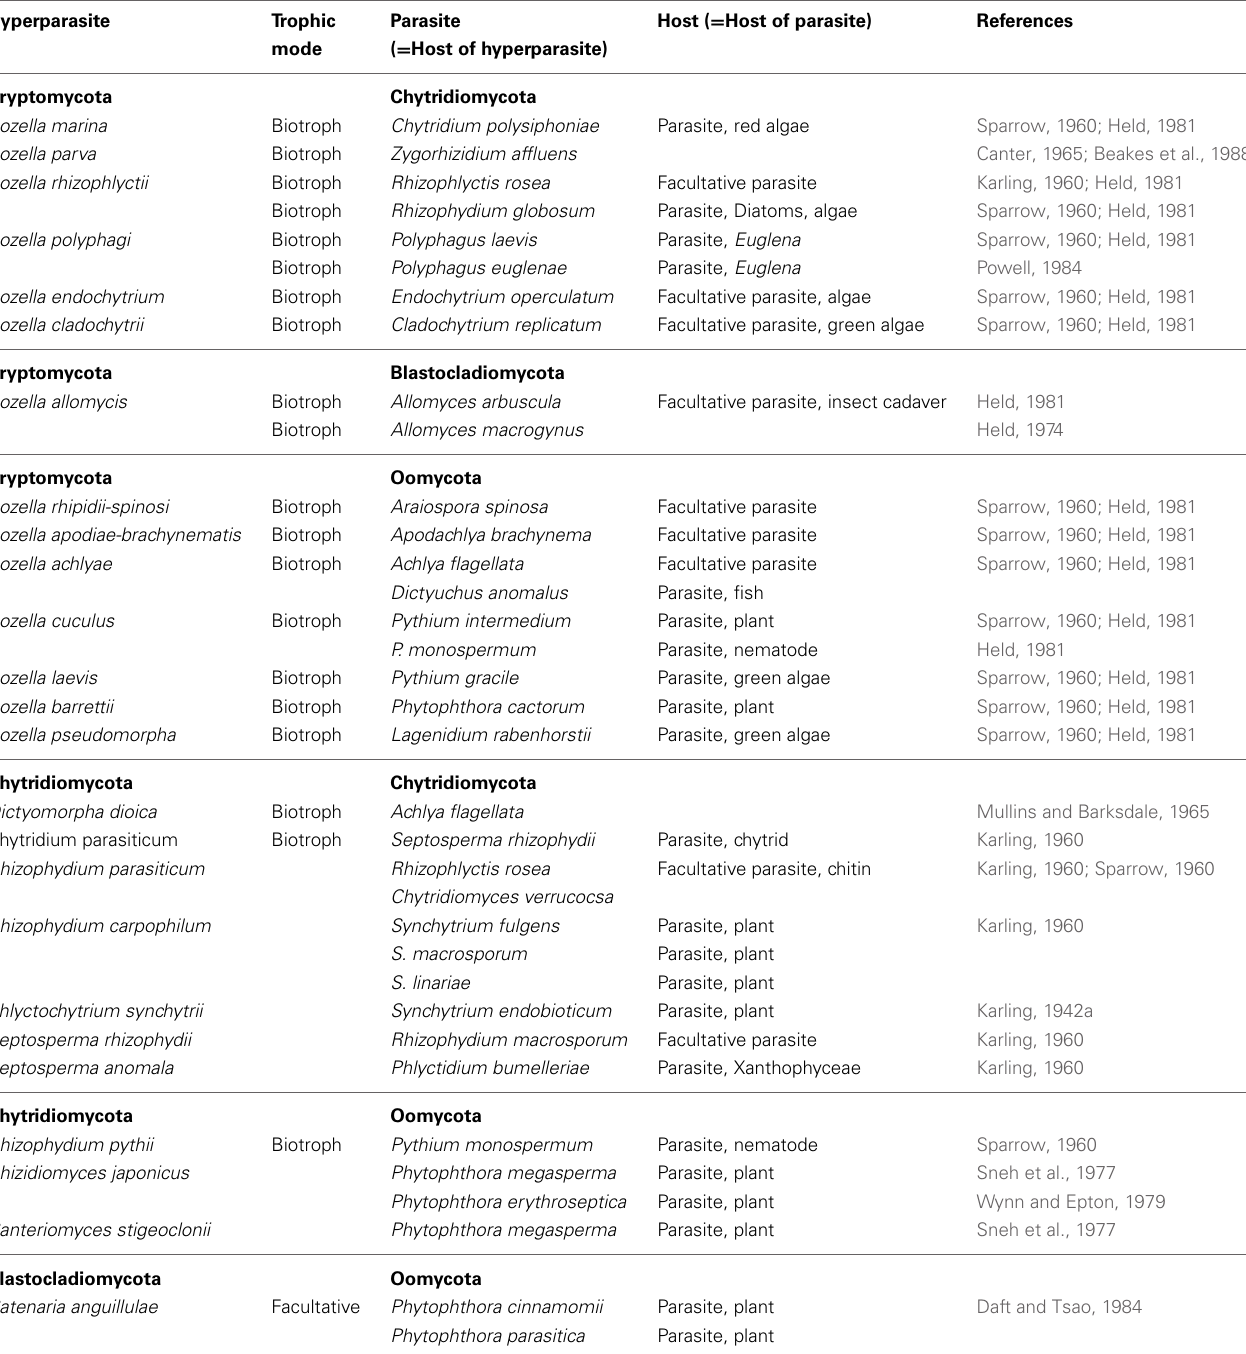
Table 1 | Selected hyperparasitic Opistokonts (Chytridiomycota, Cryptomycota, Blastocladiomycota).